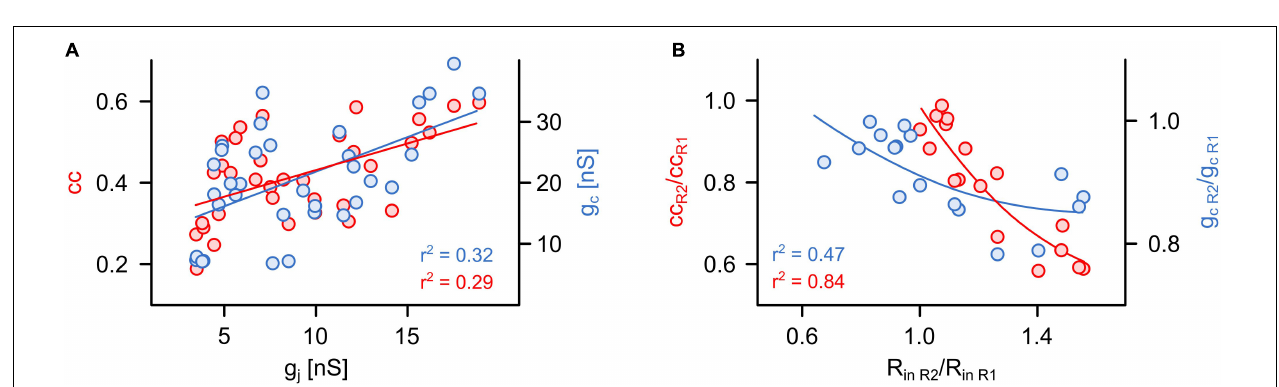
FIGURE 2 | Symmetry of synaptic electrical transmission is best described by voltage-clamp based measurements of gap junction conductance. (A) The coupling coefficient (cc), (B) the coupling conductance (g c ) and (C) the junctional conductance (g j ) were determined in the same Retzius (R) cell pair in both directions ( n = 17 pairs). The R cells with the smaller cc, g c , or g j were combined into one group (R2). The R cells with the larger cc, g c , or g j were combined into another group (R1). The mean coupling symmetry of each approach was defined as the ratio of respective values in R2 to R1. (D–F) Comparison of the smaller (R2) vs. the larger (R1) cc, g c , or g j measured in both directions of coupling for each cell pair. Dashed lines indicate identical cc, g c , or g j in both directions (slope = 1) and thus represent symmetrical coupling.